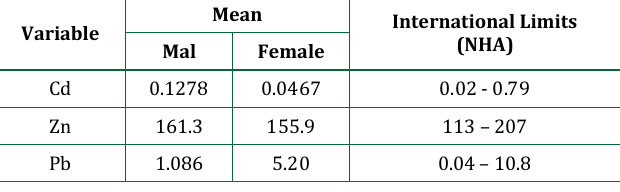
Table 5: Distribution and Mean Concentration (mg/kg) of Heavy Metal in The Population Sample